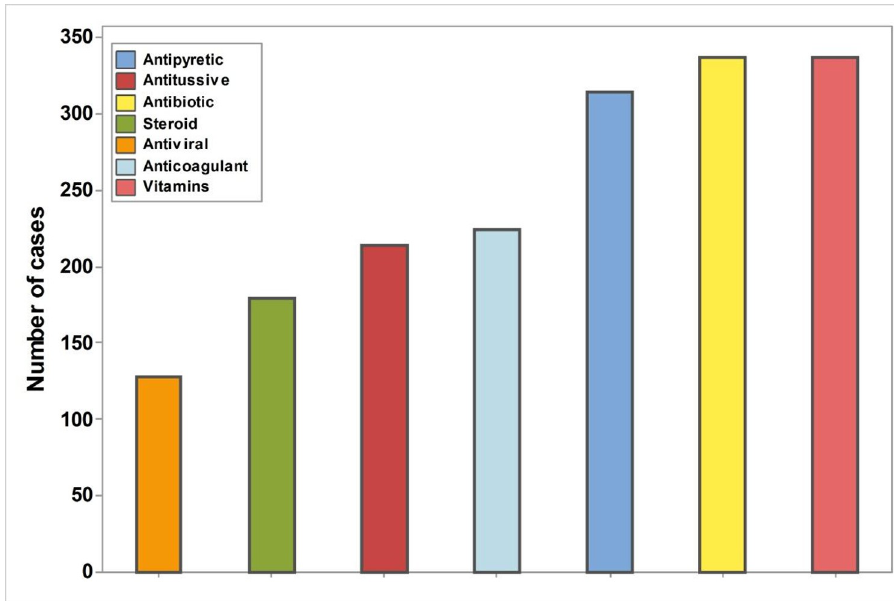
Fig 2. Frequency of drugs used for treatment of